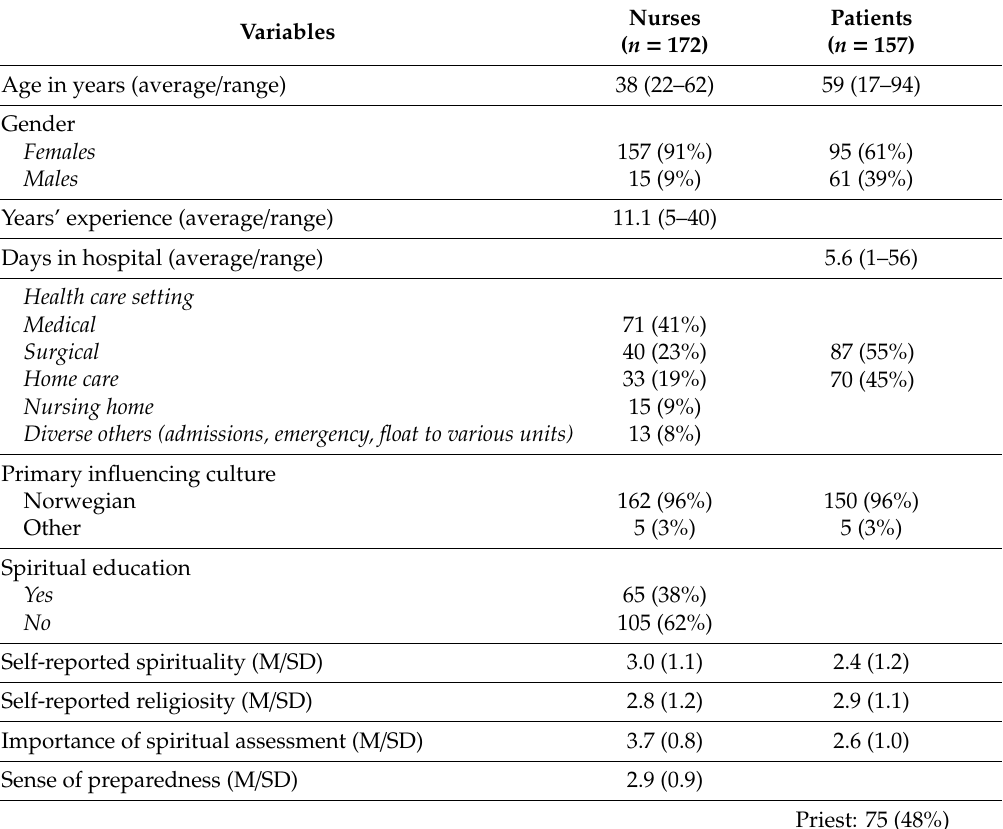
Table 2. Participants’